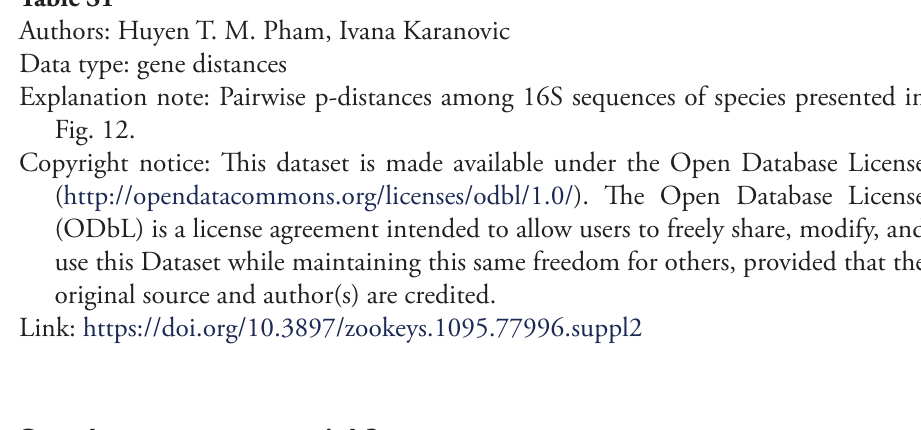
Authors: Huyen T. M. Pham, Ivana Karanovic Data type: gene distances Fig. 12.